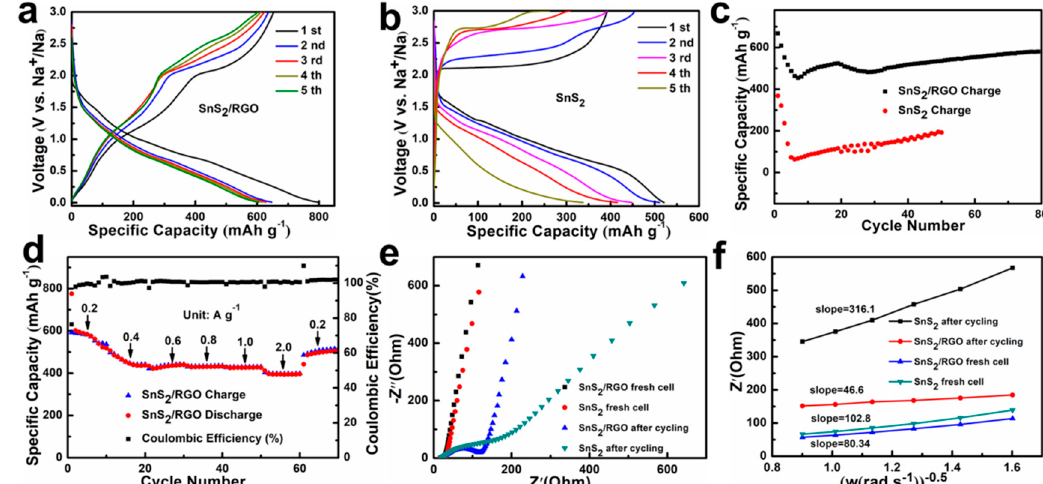
Figure 4. ( a , b ) Discharge/charge curves of SnS 2 /RGO and SnS 2 at 0.1 A g − 1 . ( c ) The cycling performance of SnS 2 /RGO and SnS 2 at 0.5 A g − 1 . ( d ) Rate capability at different current densities (0.2–2 A g − 1 ). ( e ) The electrochemical impedance spectra of the SnS 2 /RGO and SnS 2 were obtained before and after 10 cycles at 0.2 A g − 1 . ( f ) The relationship between the Z re and ω − 1/2 in the low frequency of SnS 2 /RGO and SnS 2 .